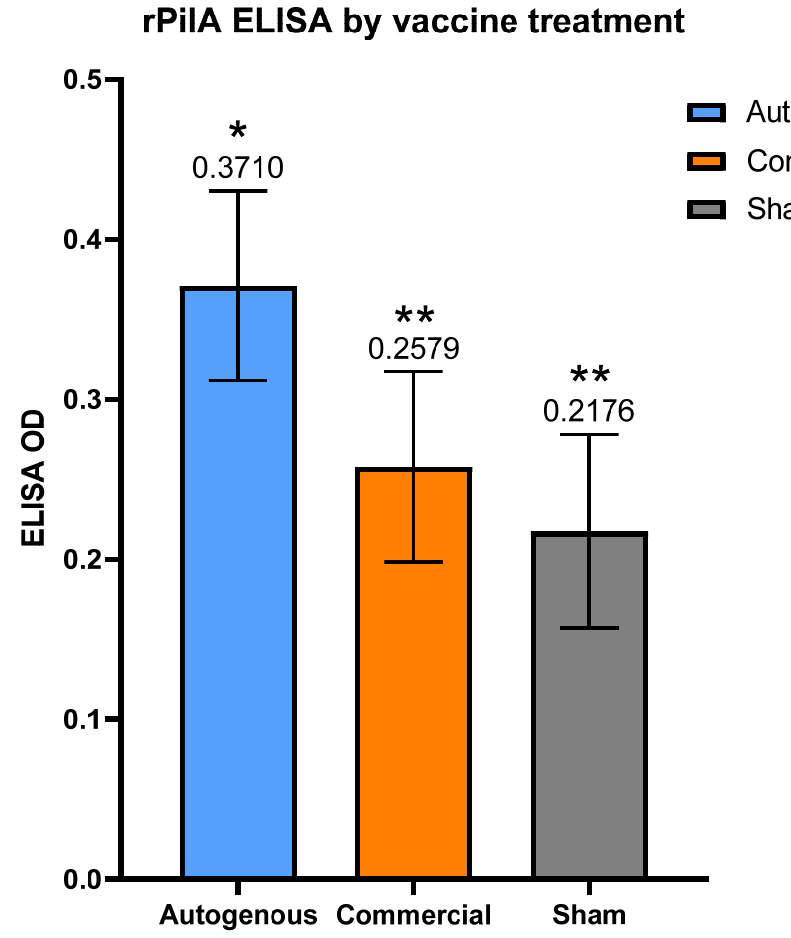
Figure 5. ELISA OD readings by vaccine treatment groups. Adjusted p of 0.0224 when comparing Autogenous and Commercial. Adjusted p of 0.0013 when comparing Autogenous and Sham. Error bars indicate 95% confidence limits. * vs. ** indicates significantly different values.